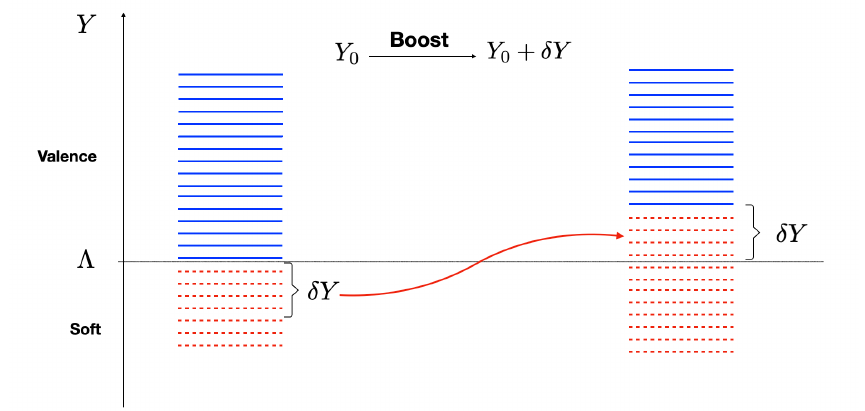
Figure 1 . The longitudinal momenta of the fast moving hadrons (projectiles) are divided into valence modes and soft modes with a separation scale Λ . After a differential boost of δY , the soft modes within the range δY right below the cutoff Λ will emerge above Λ